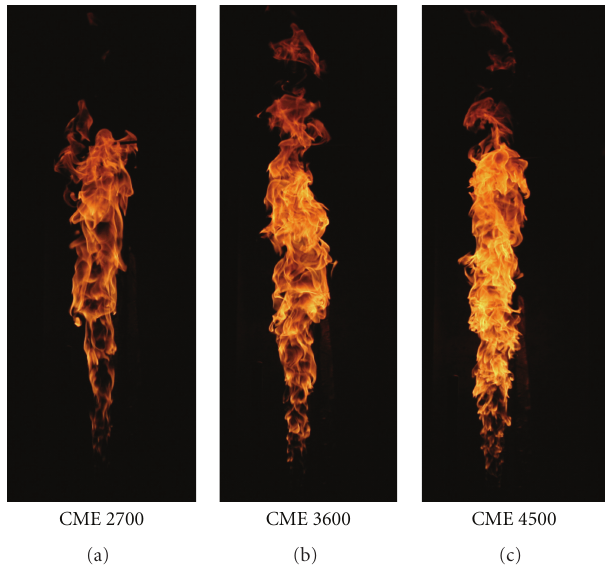
Figure 3: CME flame photographs with exposure time of 1/4000